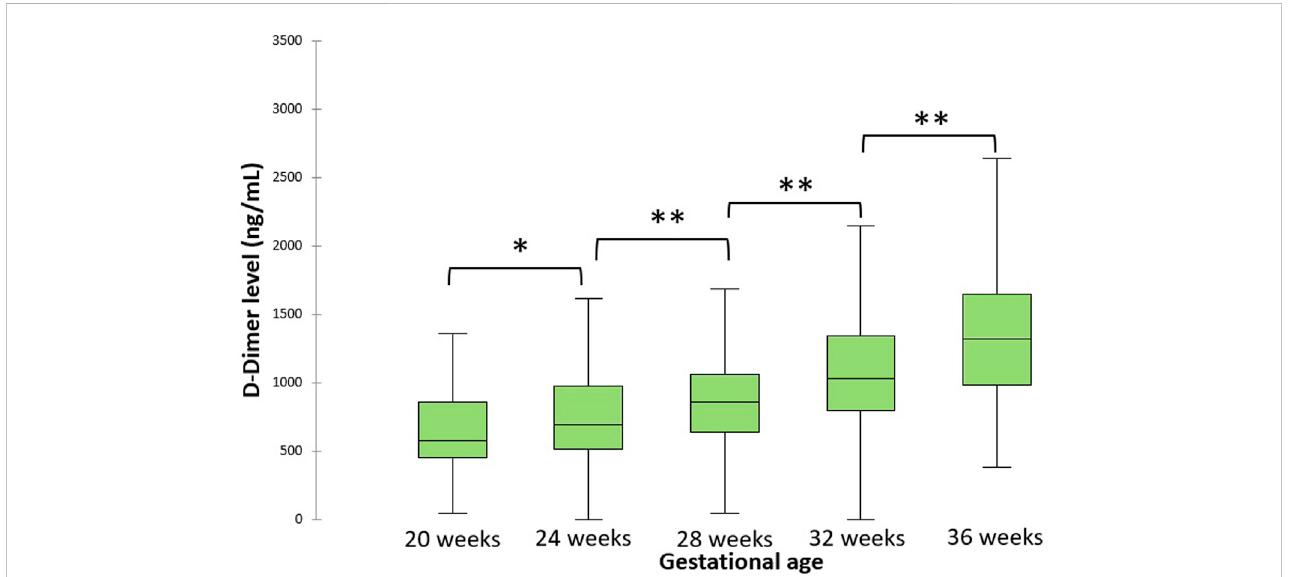
FIGURE 1 Evolution of D-dimer levels during pregnancy for all population. The central horizontal barsare themedians. The lowerand upperlimits of theboxes are the fi rst and third quartiles. * p -value < .05; ** p -value < .001.